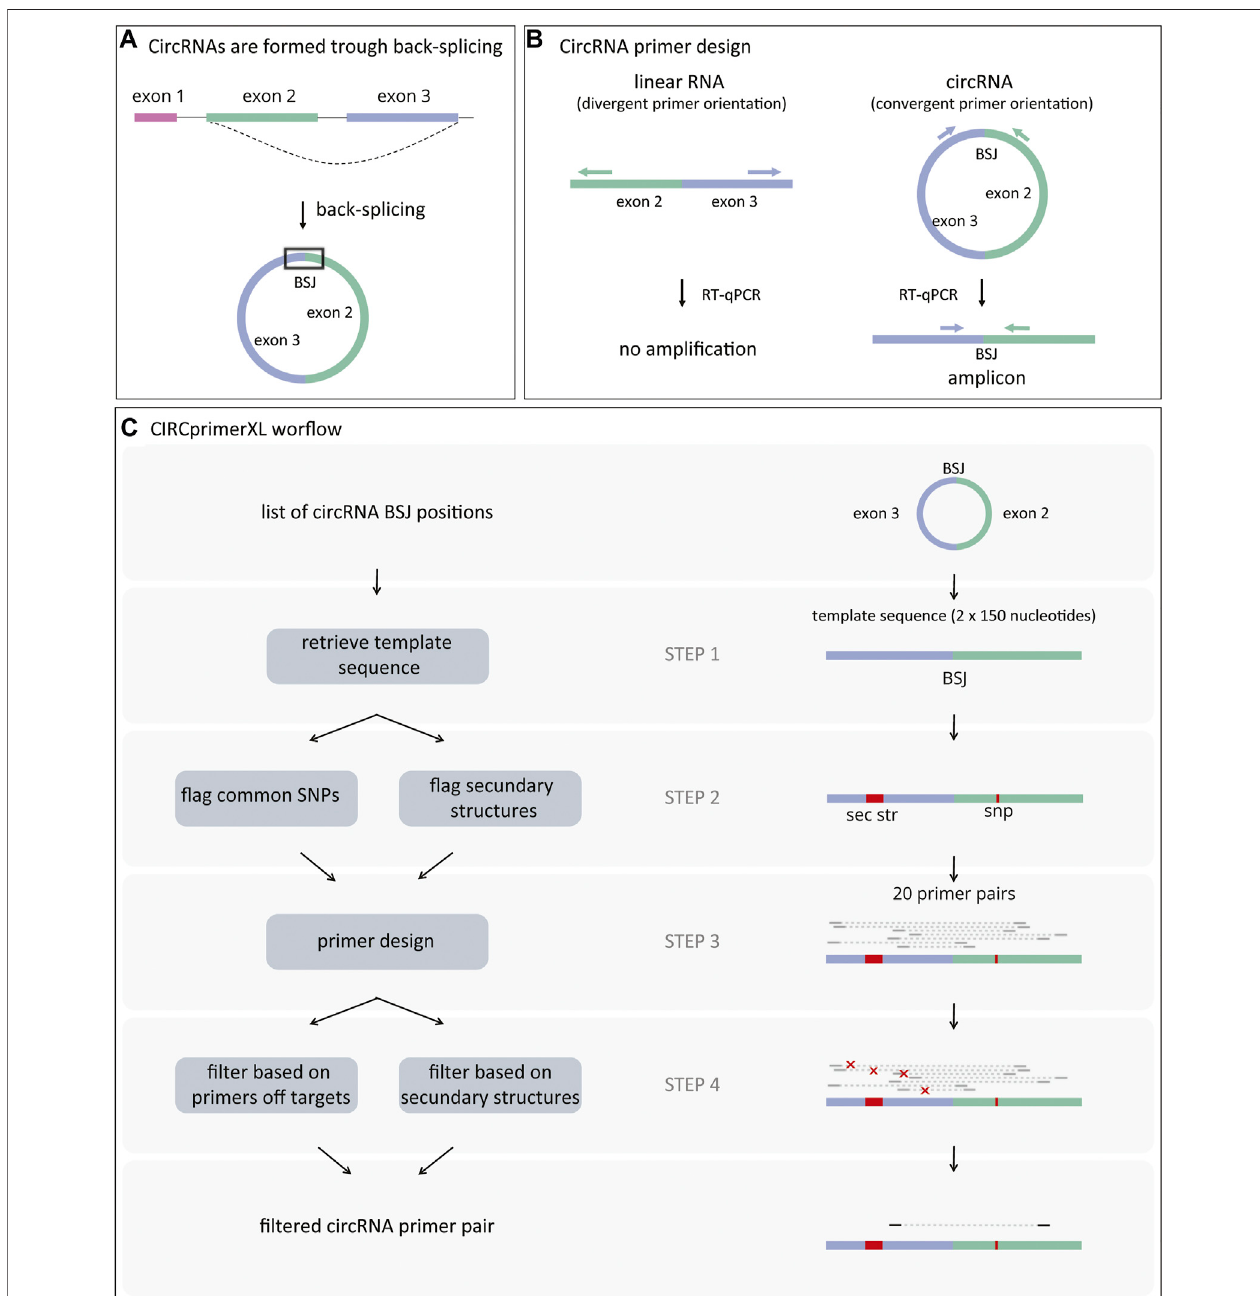
FIGURE 1 | CircRNAs formation and primer design. (A) CircRNAs are formed through a process called back-splicing, which results in a covalently closed loop characterized by a back-splice junction (BSJ). (B) CircRNA-speci fi c primers amplify the region surrounding the BSJ when annealing to the circRNA (convergent orientation).TheseprimerswillnotamplifylinearRNA(divergentorientation). (C) First,CIRCprimerXLretrievesthesequencesurroundingthecircRNABSJ(step1).Next, bothcommonSNPsandregionswithsecondarystructuresare fl agged(step2)andavoidedduringprimersdesign(step3).Finally,theprimersare fi lteredbasedon their speci fi city and secondary structures in the amplicon (step